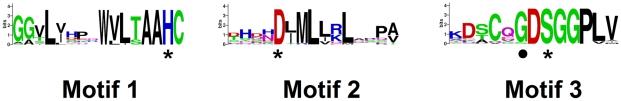
Sequence logo of the three catalytic motifs present in KLKs.The number of each of the motifs is indicated below. The height of each letter is proportional to the frequency of the corresponding residue at that position, and the letters are ordered so the most frequent is on top. The conserved catalytic triad residues are indicated with asterisks. The dot indicates the conserved glycine residue present in the oxyanion hole.